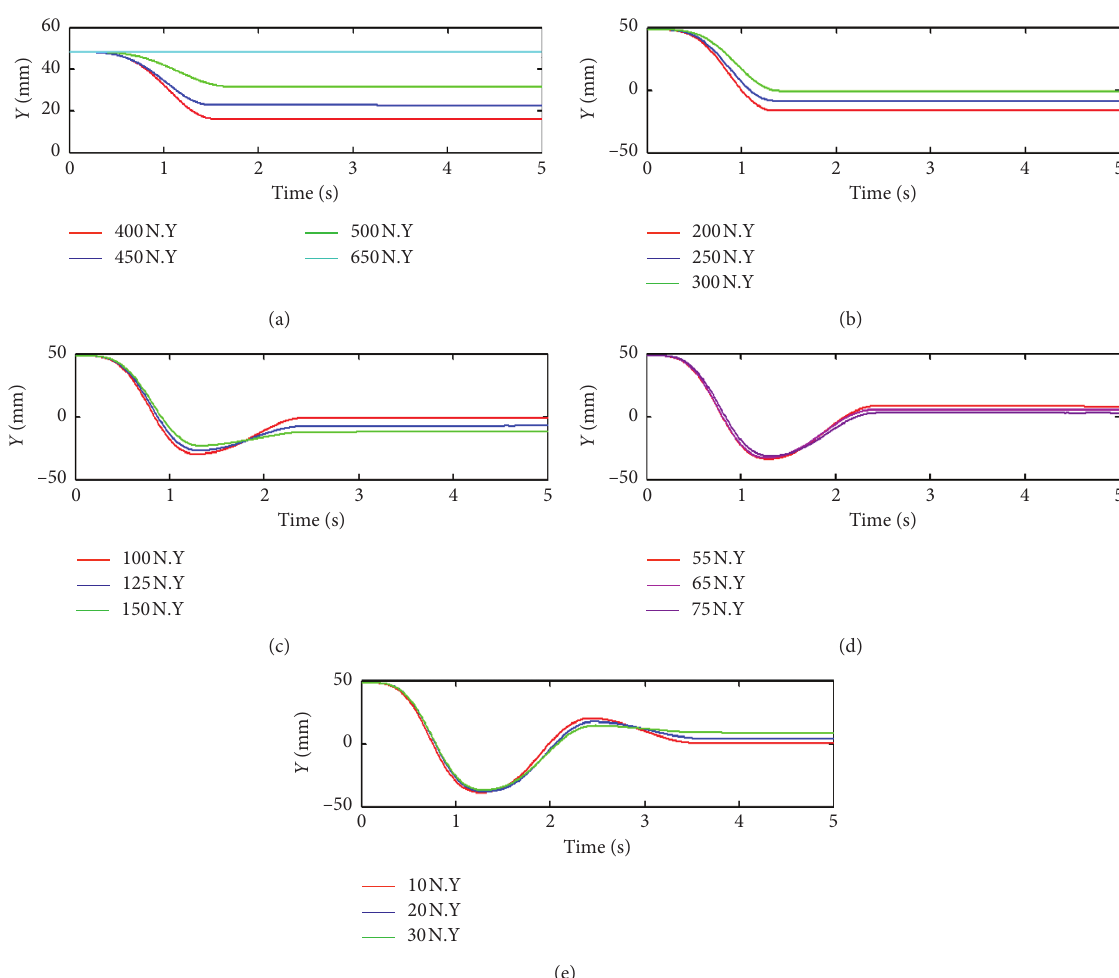
Figure 14: The oscillation curve of the center of mass of the platform in Y direction when β � ( π /20 ) and ϕ � ( π /2 ) under different loads between the upper and lower disc